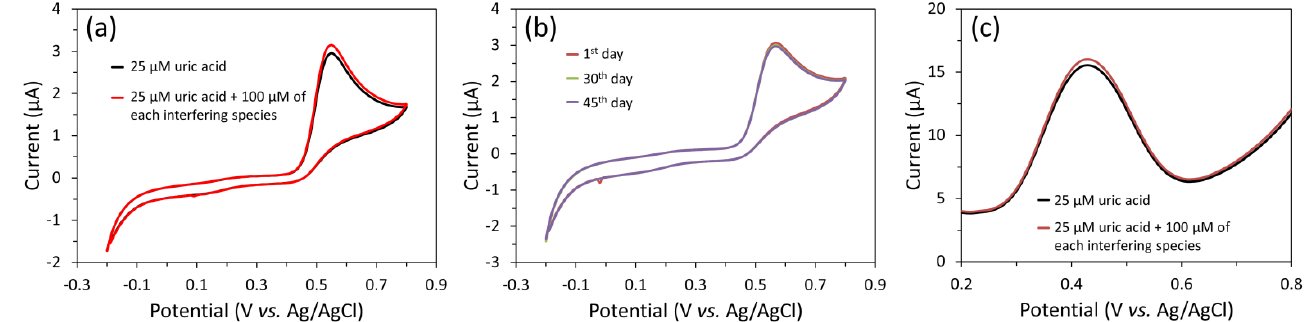
Figure 7. ( a ) CV response curves recorded for cobalt oxide/GCE sensor in PBS with 25 µ M uric acid only (black curve) and 25 µ M uric acid and 100 µ M of each interfering species (i.e., lactic acid, L − cysteine, glucose, urea, fructose, sodium chloride, and potassium chloride) (red curve). ( b ) CV response curves of cobalt oxide/GCE sensor for 25 µ M uric acid showing stability of sensor after 30 and 45 days. ( c ) DPV response curves for 25 µ M uric acid only (black curve) and 25 µ M uric acid and 100 µ M of each interfering species (i.e., ascorbic acid, dopamine, and urea).